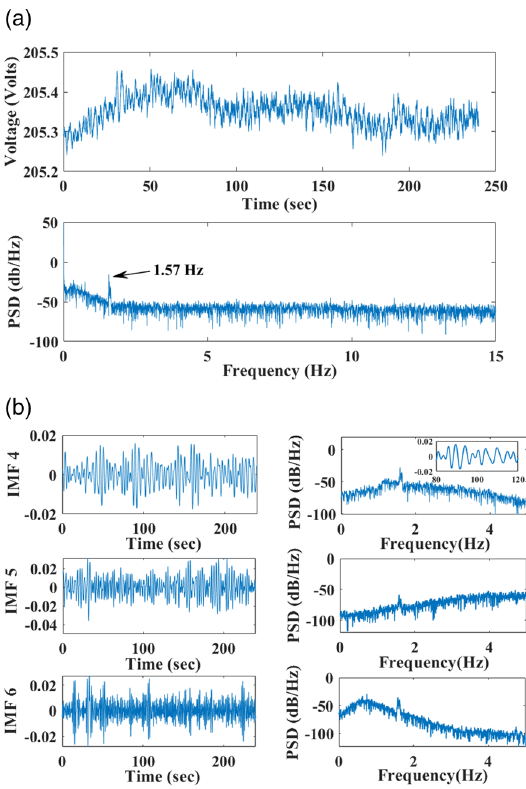
Fig. 12 a Actual raw PMU signal and its PSD at substation 4. b Decomposed modes of the raw PMU